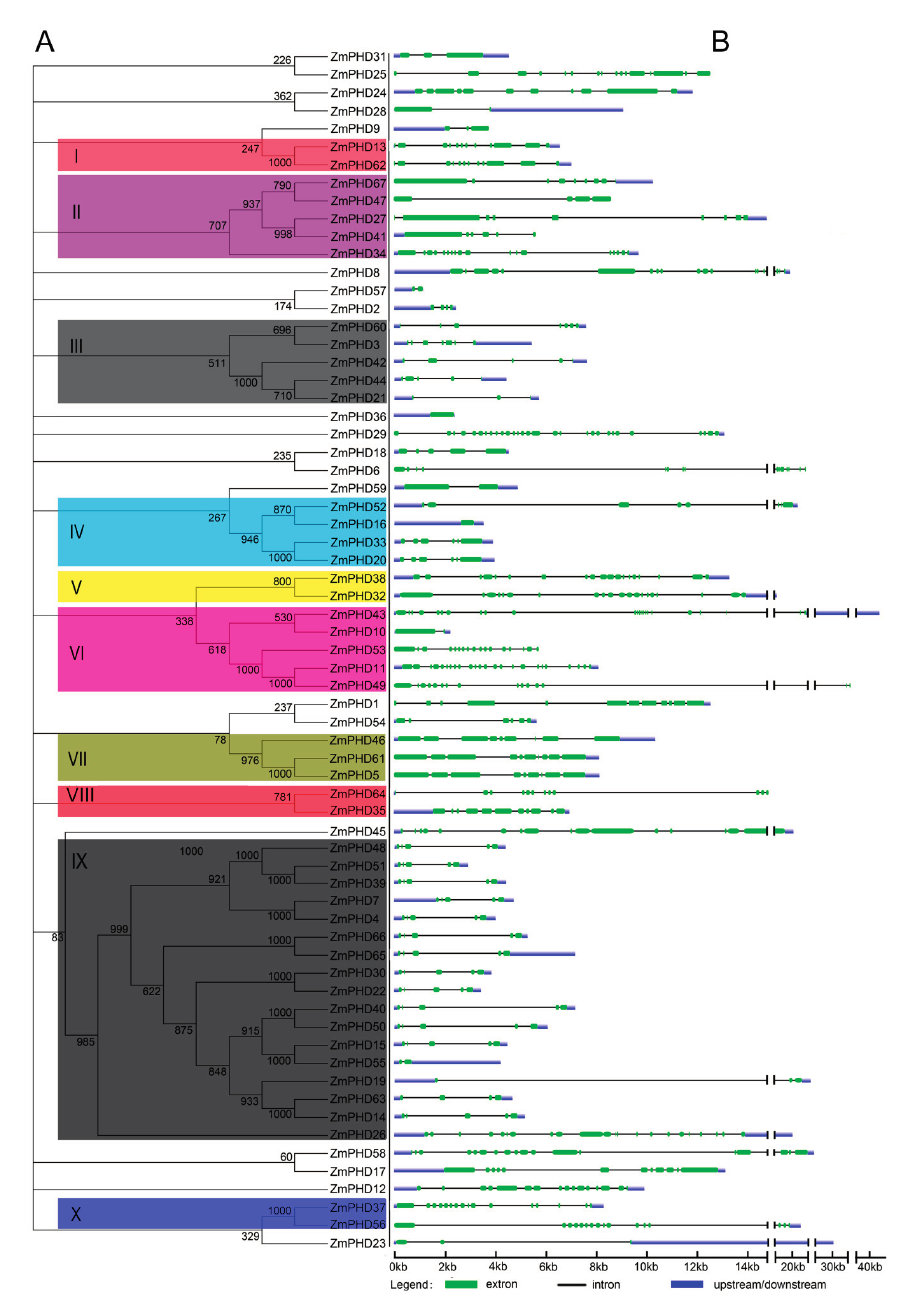
Figure 1. Phylogenetic relationships and gene structure of maize PHD genes. ( A ) An unrooted tree is generated with the MEGA4.0 software using the full-length amino acid sequences of the 67 maize PHD proteins by the Neighbor-Joining (NJ) method, with 1000 bootstrap replicates. The tree shows ten major phylogenetic groups (group I to X) indicated with different colored backgrounds; and ( B ) Exon/intron organization of maize PHD genes. Green boxes indicate exons and grey lines represent introns, and the untranslated regions (UTRs) are indicated by blue boxes. The sizes of exons and introns can be estimated using the scale at the